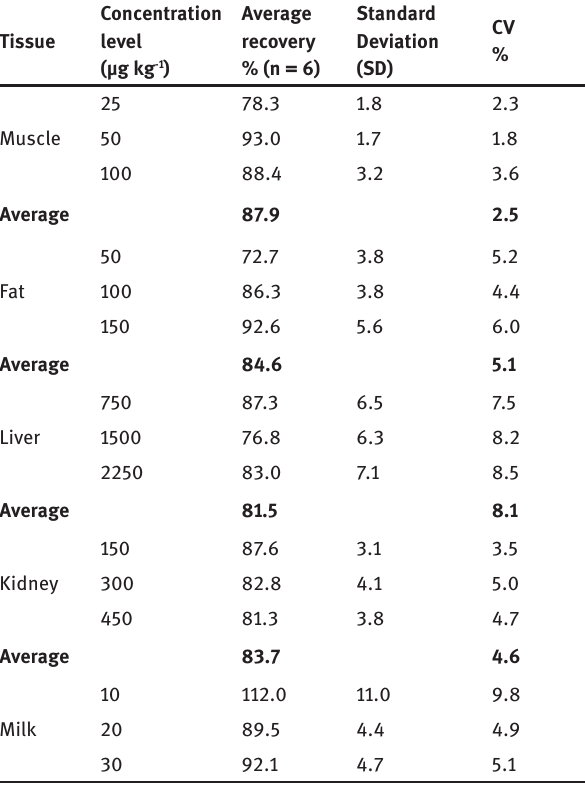
Table 5: Recovery from fortified samples (0.5 × MRL, 1 × MRL and 1.5 × MRL) analysed in different days.